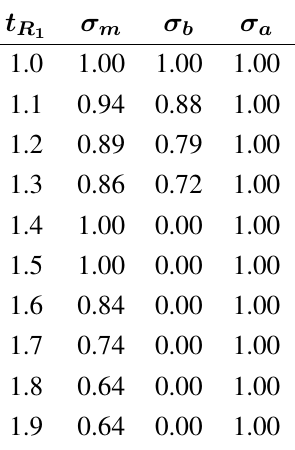
Table 4. Speeds for different response time threshold. ρ = 0.5, MTBF = 5 years, N = 100,000, W = 1